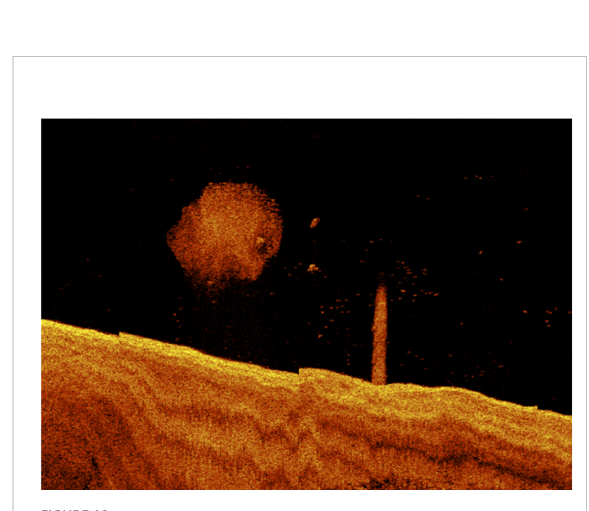
FIGURE 10 Example of potential predator-prey interaction from deeper industrial port areas recorded in sonar sampling at night